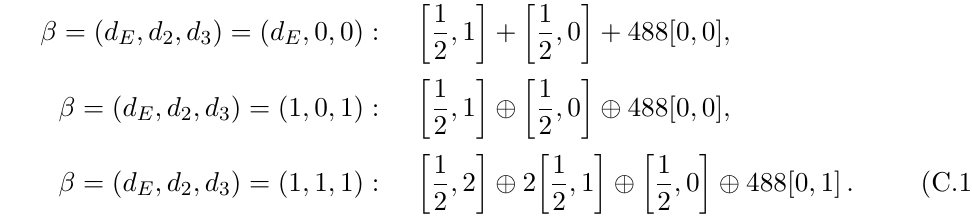
Table 16 . The refined GV numbers n g L ,g R the integer basis.